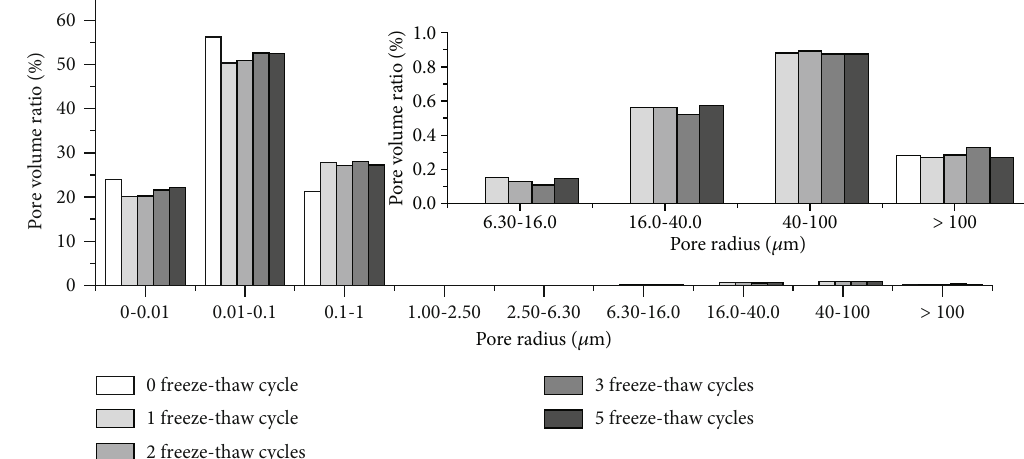
Figure 7: The proportion of accumulated pore volume with di ff erent freeze-thaw